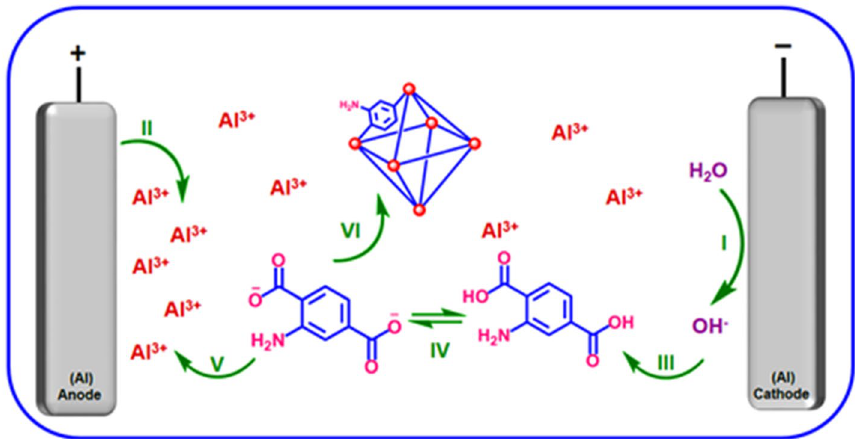
Figure 6. Preparation of MIL-53(Al)-NH 2 using anodic electrosynthesis